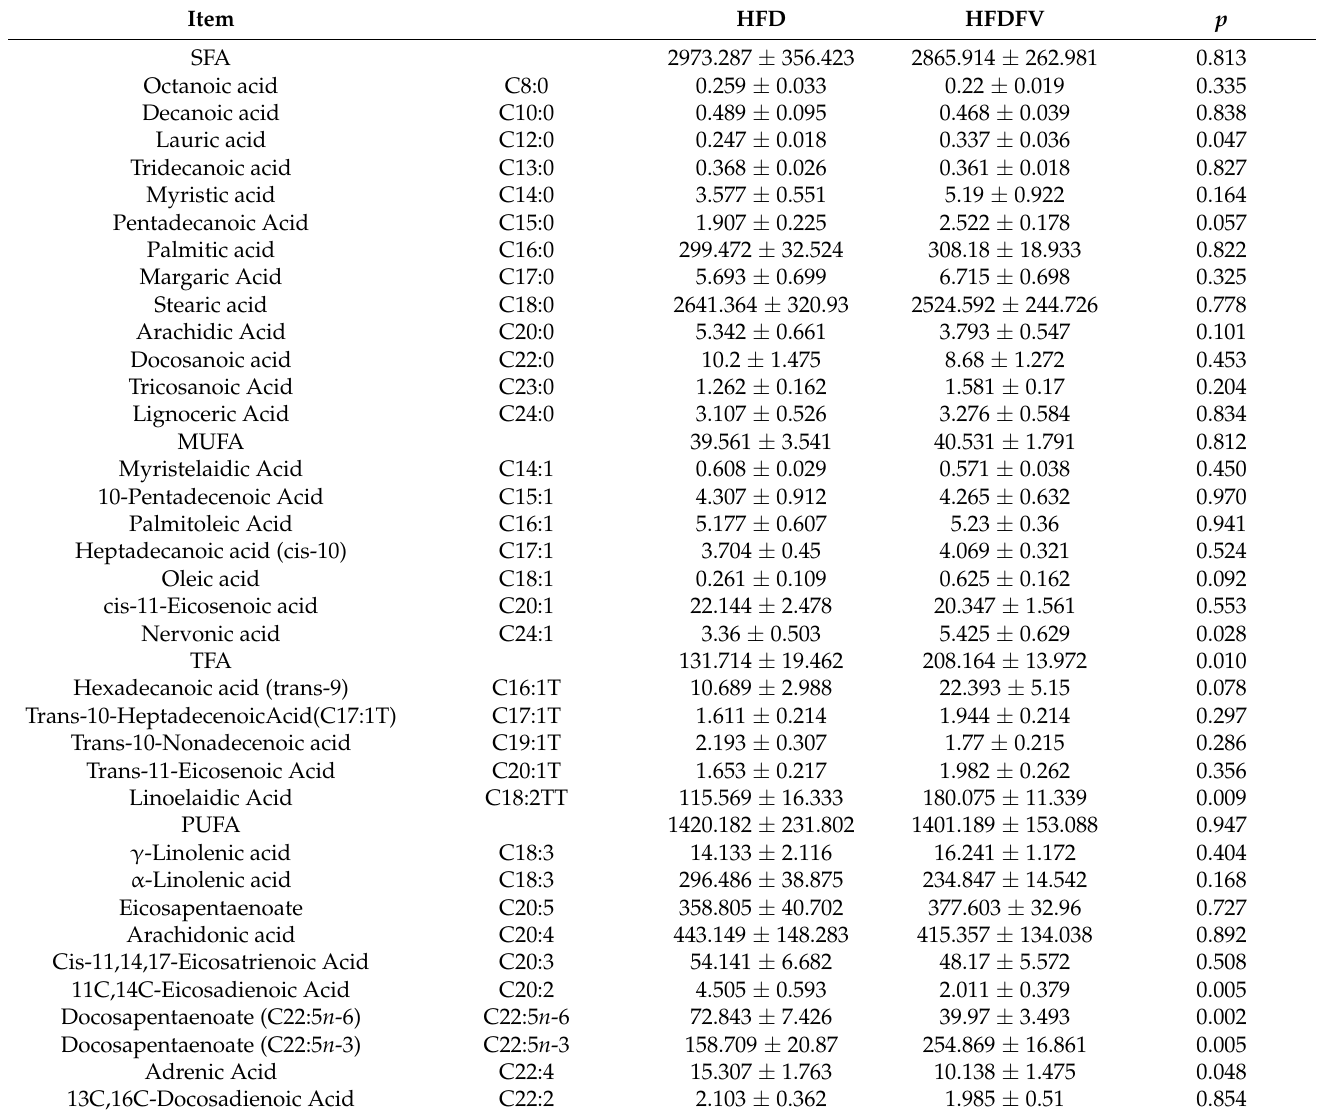
Table 3. Effects of FV mycorrhizae on HFD-induced medium long chain fatty acids profiles (mg/g Tissue) in the